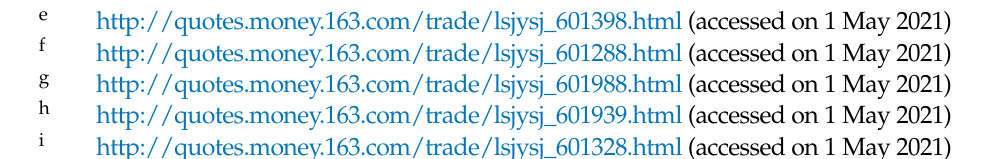
Figure 8. Change of stock opening prices of five stated